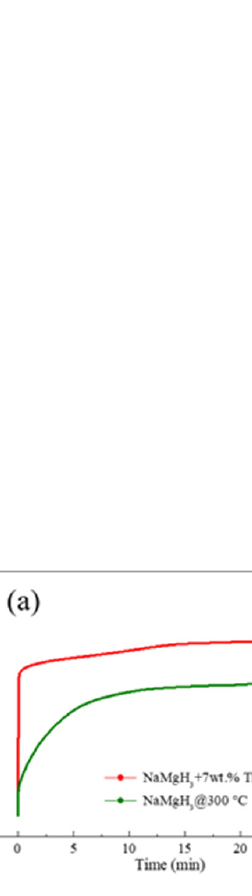
Figure 6. Isothermal hydrogenation curves of pure NaMgH 3 and NaMgH 3 -7 wt.% Ti 3 C 2 at different temperatures. ( a ) 300 °C ( b ) 350 °C ( c ) 400 °C.